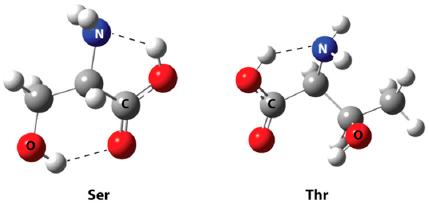
Figure 3. Optimized geometries of Serine and Threonine amino acids at B3LYP/6-31+G(d,p) level of theory with their respective intramolecular HBs as dashed lines.